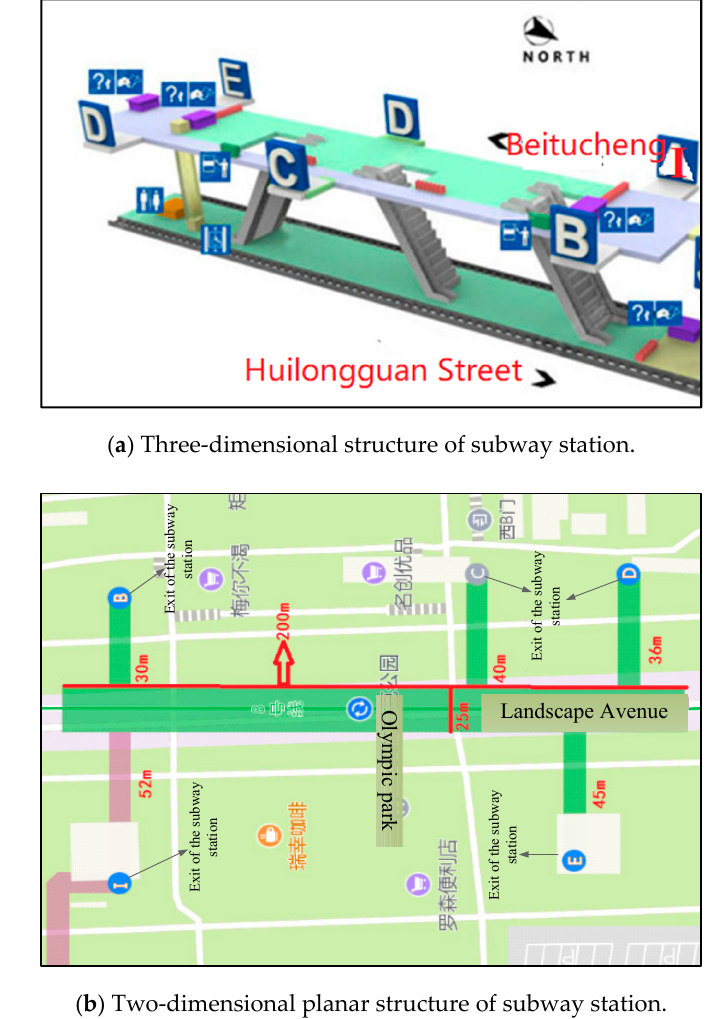
Figure 2. Layout of “Olympic Park Station”.